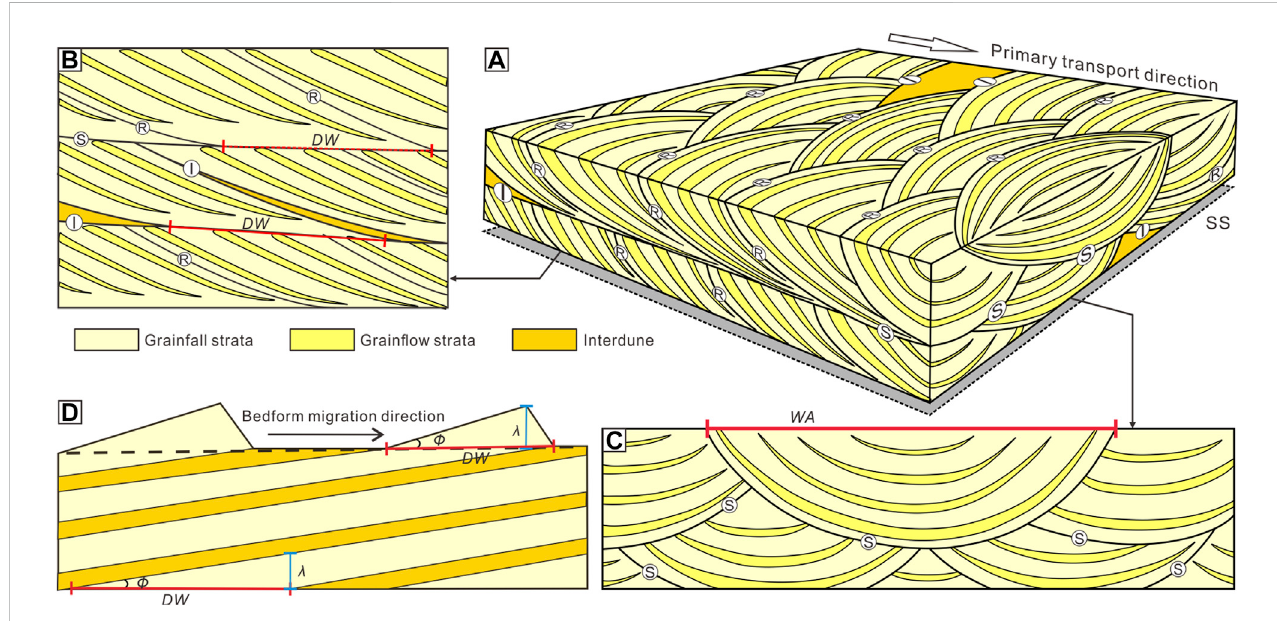
FIGURE 2 Geometricmodelsof aeolian architectureofancient dunes. (A) Depositional model for aeolian dune and interdune deposits(modi fi edfrom Romain and Mountney,2014). (B) Crosssectionparalleltotheprimarytransportdirection. (C) Crosssectionperpendiculartotheprimarytransportdirection. (D) Simpli fi ed model for the accumulation of aeolian succession (modi fi ed from Mountney, 2012). SS-Supersurface; I-interdune surface; S-superimposed surface; R-reactivation surface; DW -dune wavelength; WA -dune wave width; λ -preserved set thickness; ϕ -angle of set